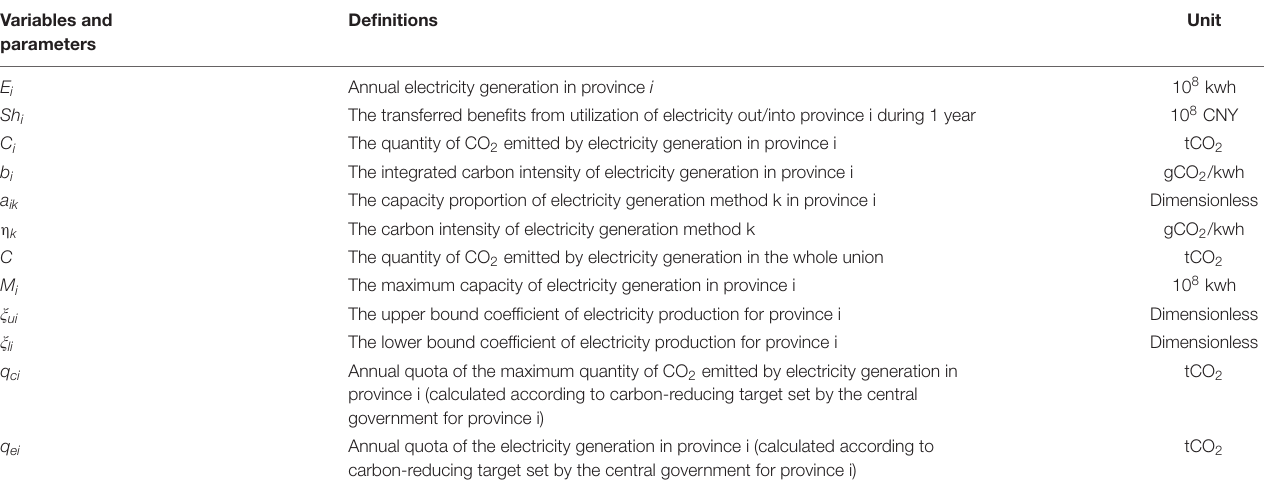
TABLE 1 | Definitions of variables and parameters. Variables and parameters